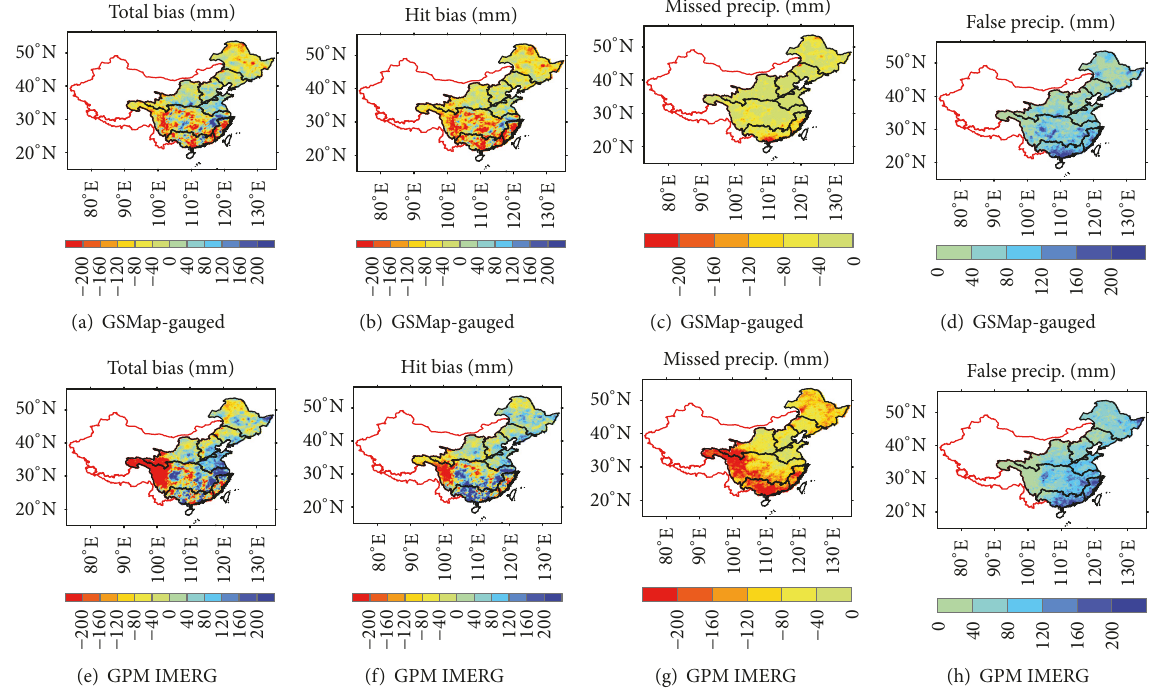
Figure 2: Total bias and three error components of GSMap-gauged and IMERG precipitation data from April 2014 to March 2016 over eastern China.